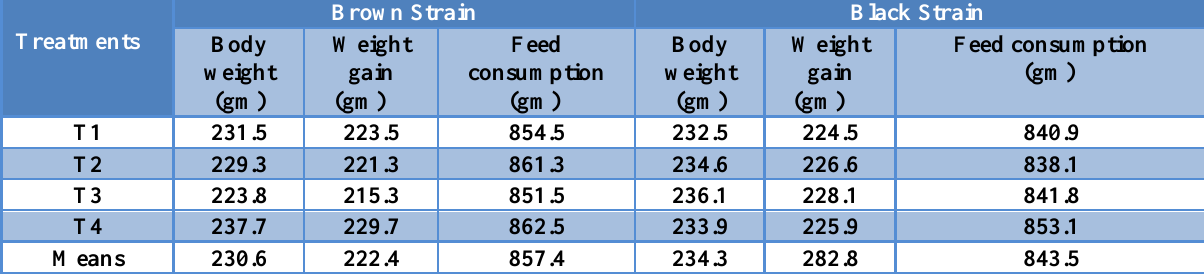
Table, 2: Effect of treatments in live weight, weight Gain, Feed Consumption for quail at 99 days old